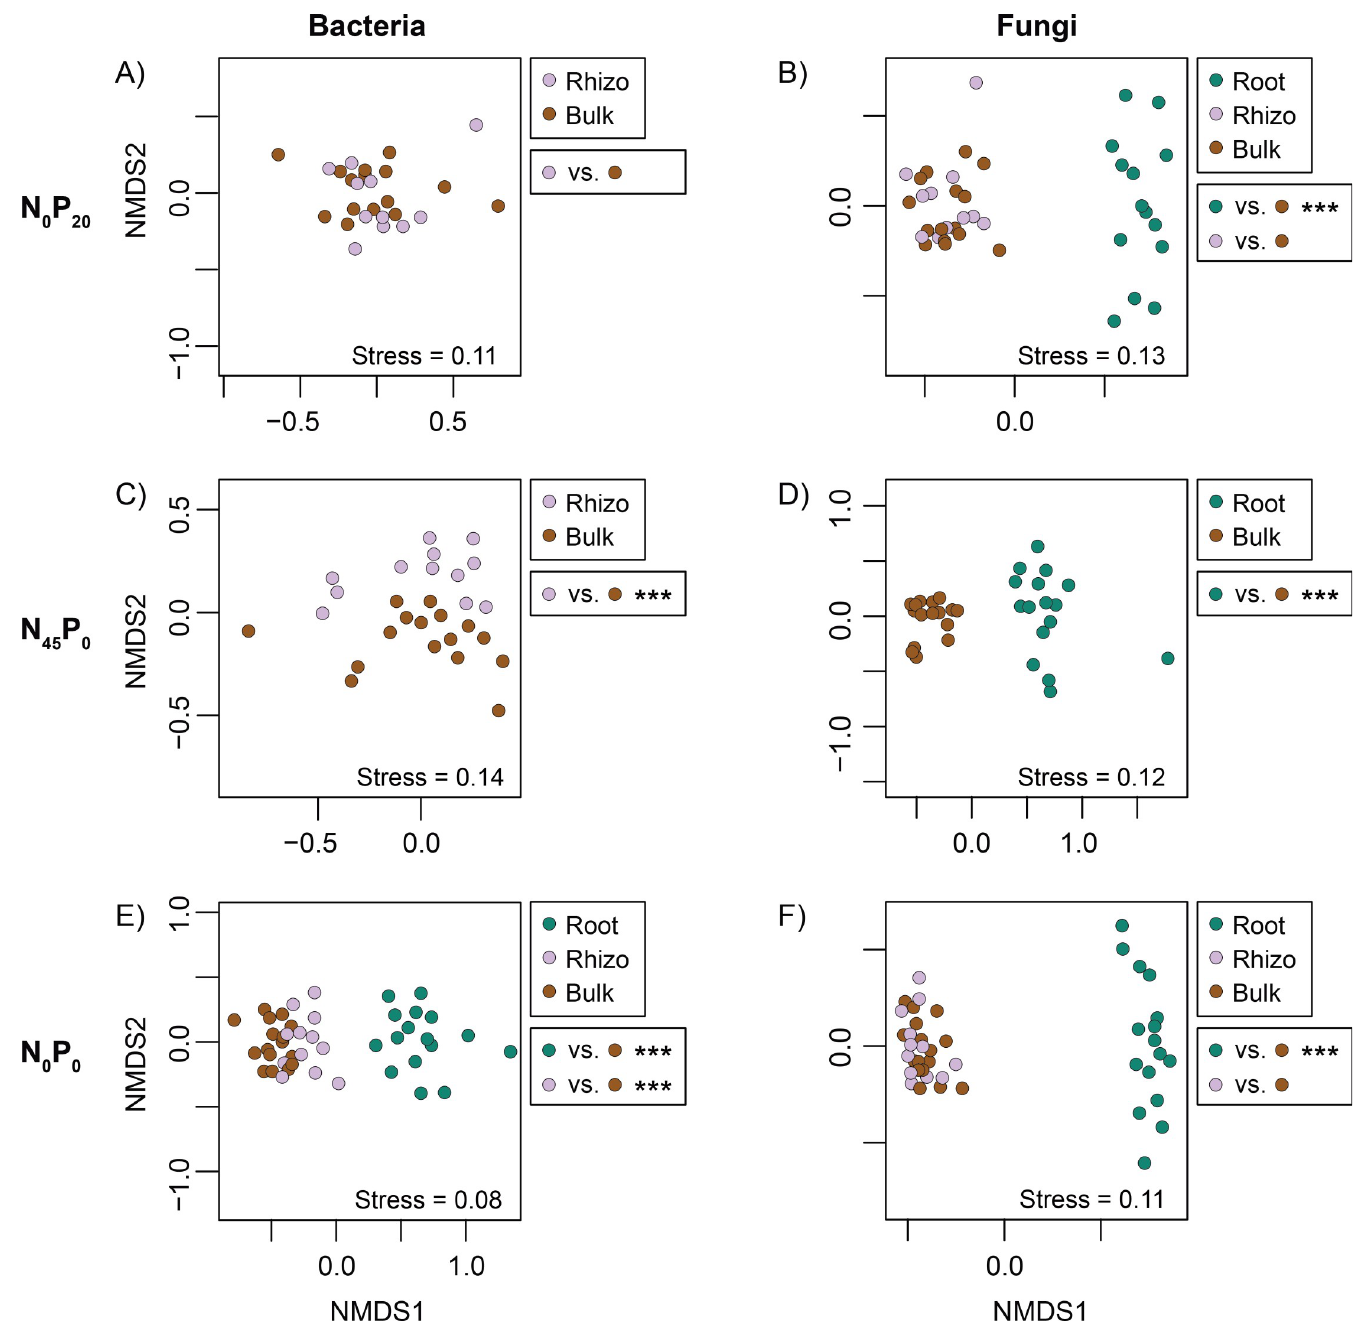
Fig 3. Microbial community comparisons—compartments. Non-metric multidimensional scaling (NMDS) ordinations representing the dissimilarity (Bray-Curtis) of microbial communities sampled from different soil/plant compartments. The significance of pairwise comparisons is reported next to each graph ( � = p < 0.05; �� = p < 0.01, ��� = p <